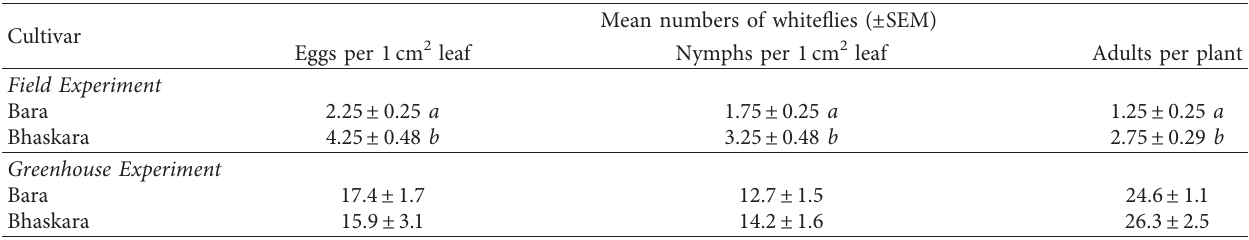
Table 2: Mean numbers of whitefly eggs, nymphs, and adults on chili cultivar treatments in field and greenhouse experiments, 2018. Cultivar